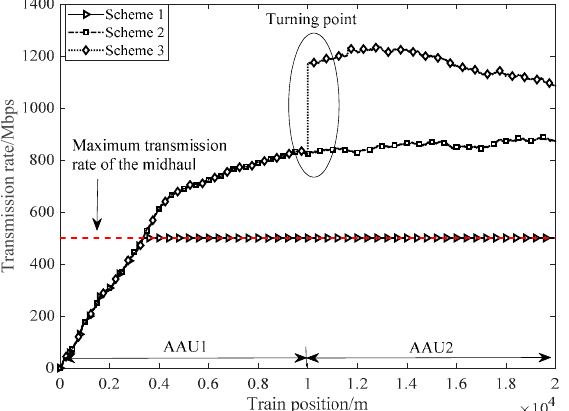
Figure 11. The network throughput at different positions.